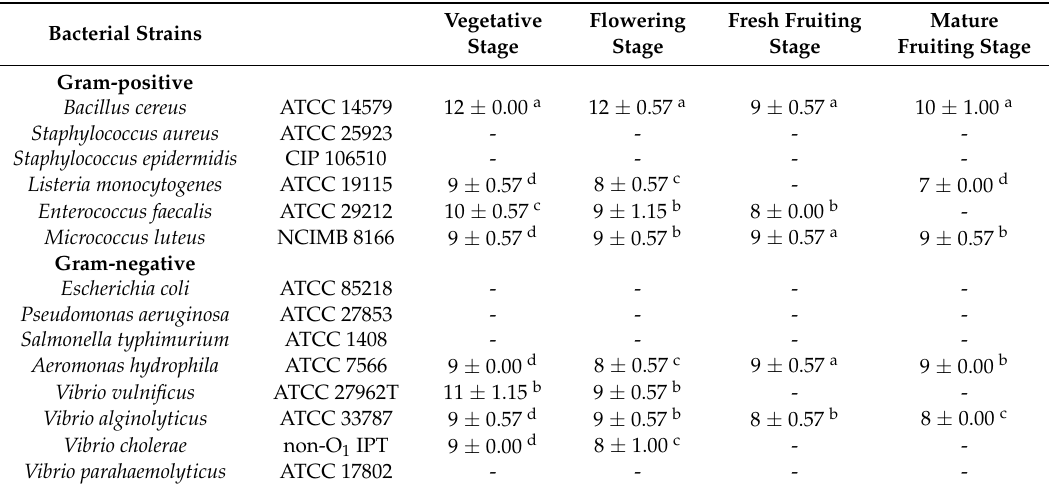
Table 5. Antibacterial activity of Retama raetam (Forssk.) Webb shoots (at 100 mg · mL − 1 ) at different grown stages against fourteen human pathogenic